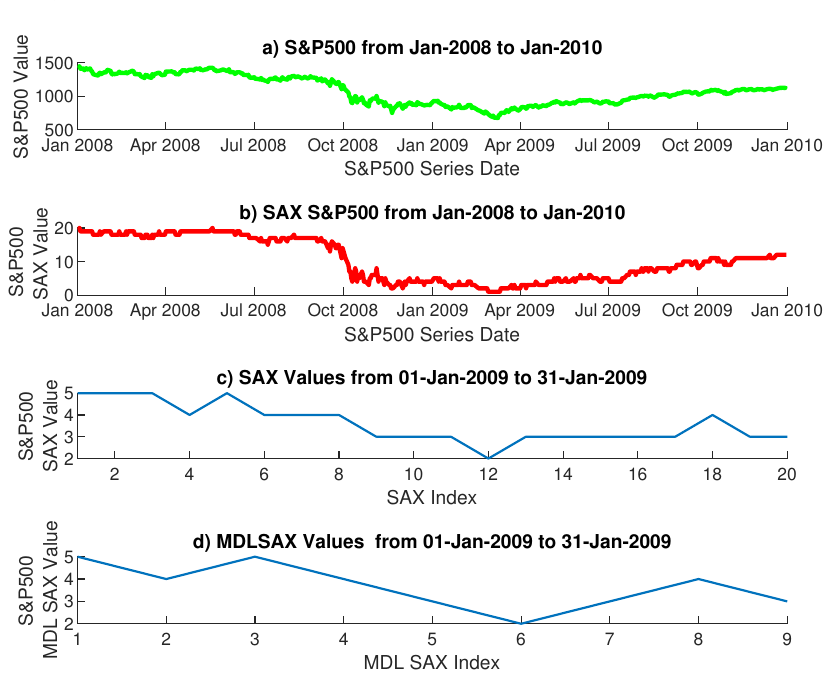
Figure 8. Sample S&P500 raw series input ( a ) to SAX string transformation ( b ). Note the length reduction between the SAX ( c ) and MDL-SAX ( d ) representations for January S&P500